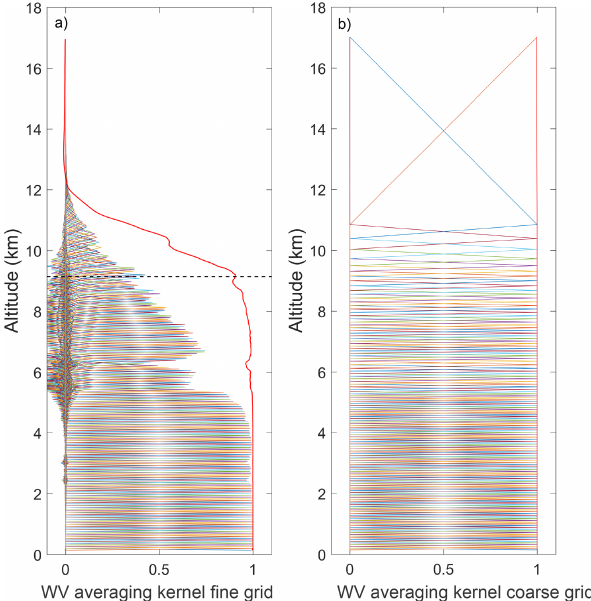
Figure 9. The averaging kernel matrix for the nighttime water vapor retrieval on 24 April 2013 00:00UT. (a) The fine-grid retrieval with a maximum altitude of 9.1km (black dashed line). The measure- ment response is shown in red. (b) The coarse-grid retrieval, where each averaging kernel is 1 for all